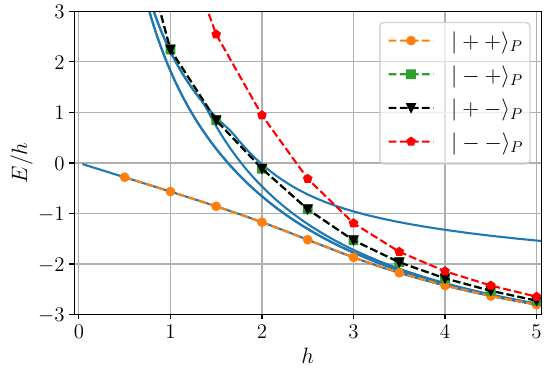
FIG. 11. Four lowest energy states in different symmetry sec- tors of the noncontractible ’t Hooft loop operators versus cou- pling strength h . All data refer to the best solution found for L = 3, P = 6, and | ψ 0 (cid:3) = | (cid:5) E (cid:3) . States different from |++(cid:3) P are obtained by acting with noncontractible Wilson loops after the unitary evolution, while the subscript P indicates that they are obtained by QAOA and are thus not exact eigenstates. The solid lines correspond to the five lowest eigenvalues obtained with exact diagonalization: the fifth eigenvalue, corresponding to the first excited state, is shown to highlight the topological gap in the deconfined phase. Only four lines are visible because |+−(cid:3) and |−+(cid:3) are exactly degenerate, as their approximations obtained with